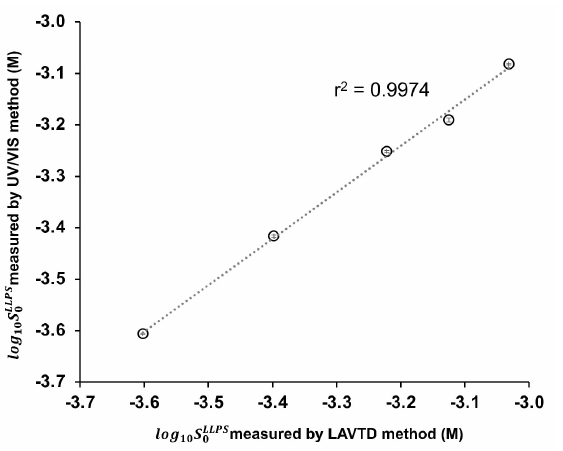
Figure 3. Comparison of the S LLPS values measured with the UV/VIS method and the LAVTD 0 method (mean ± S.D., n = 3) (298